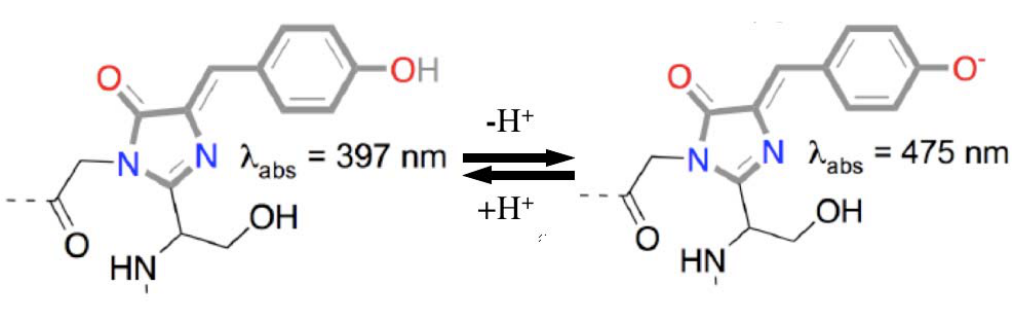
Figure 5. The dual absorption peaks in the GFP spectra are the result of different charge states in the GFP chromophore. The neutral state (left) is responsible for the major peak at 397 nm while the anionic form (right) is responsible for the minor peak at 475 nm. Regardless of the chromophore charge state, emission occurs at 504 nm. Adapted from